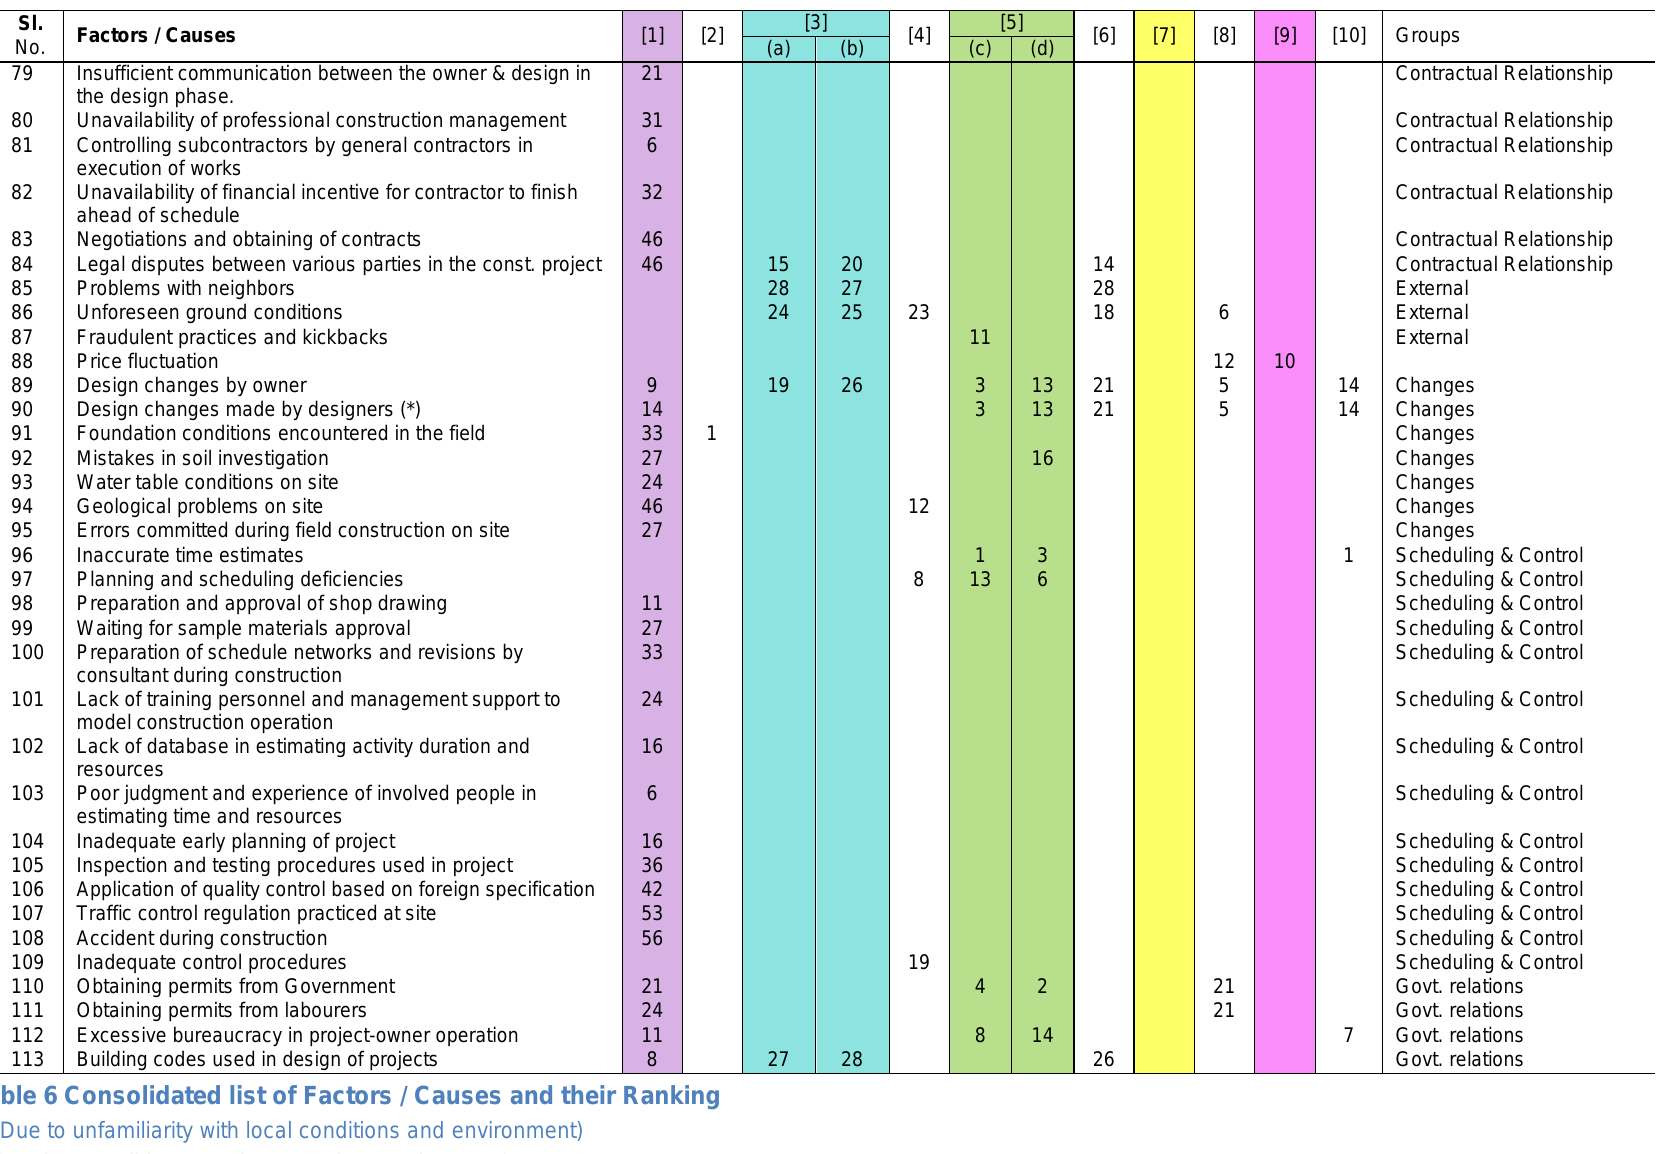
Table 6 Consolidated list of Factors / Causes and their Ranking * (Due to unfamiliarity with local conditions and environment) # (Design & Build, General Contracting, turnkey,